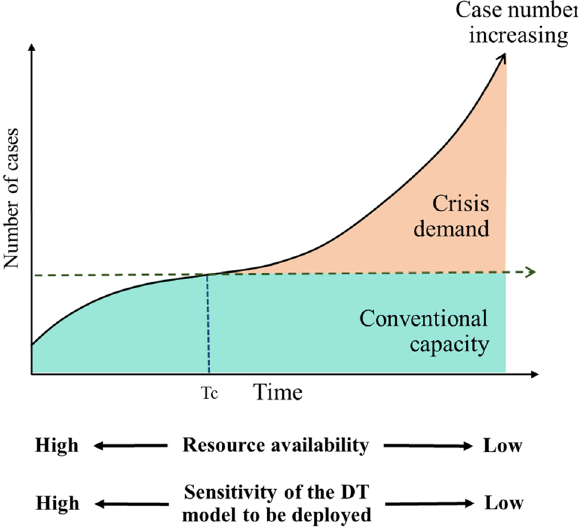
Figure 4. The curve that shows how the number of cases increases as the EID disaster progresses 61 . Beyond time point of a crisis (T c ), the medical facilities start to operate under a crisis mode. In the early stage of an EID disaster, when the healthcare capacity is adequate, the DT models with high sensitivity levels should be employed to identify patients with risk of infection progression for them to be hospitalized and receive the best treatment 9,54 . In the later stages of an EID disaster, the available medical resources may be exhausted due to a tremendous increase of patients. In this scenario, the DT models with a lower sensitivity should be employed to recommend only those patients with a high risk of progressing to severe infection or death for hospitalization and thereby avoid collapse of medical